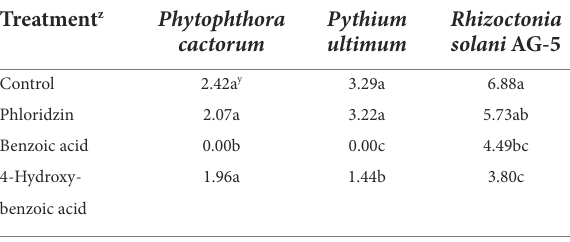
TABLE 1 Effect of select phenolic metabolites detected in apple root exudates on in vitro radial growth (cm) of targeted apple root